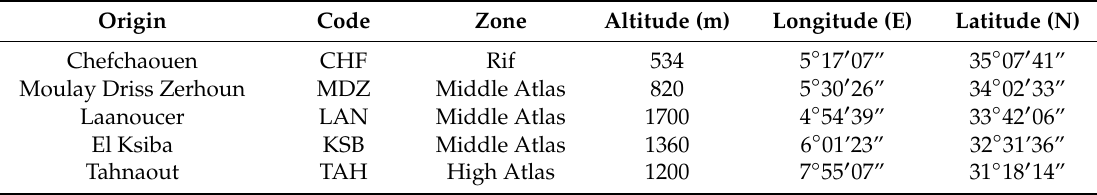
Table 1. Geographic origin of the strawberry tree genotypes